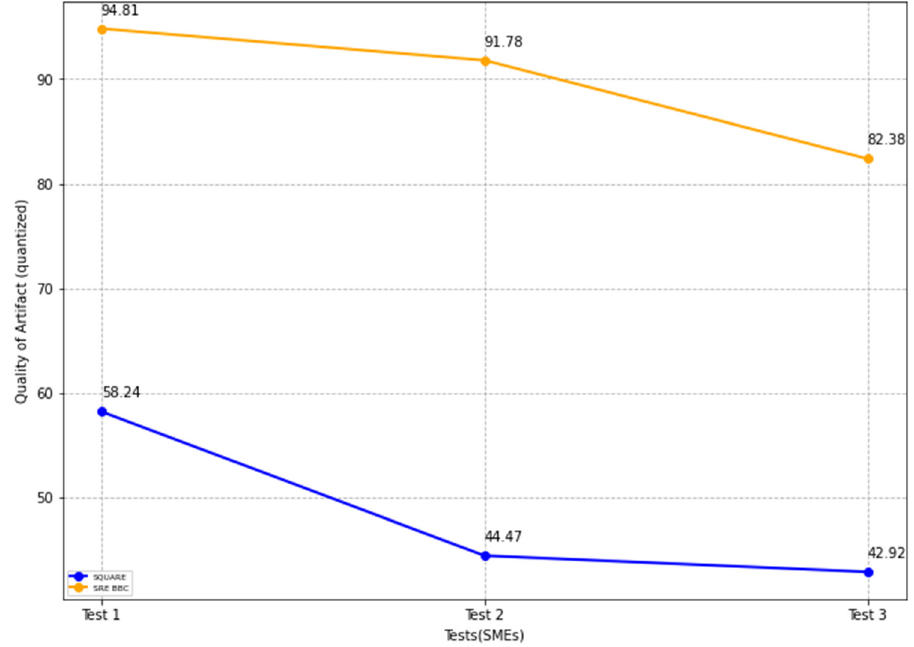
Figure 14. The comparison of quantified artifact quality for SQUARE and SRE_BBC (Feasibility Study).